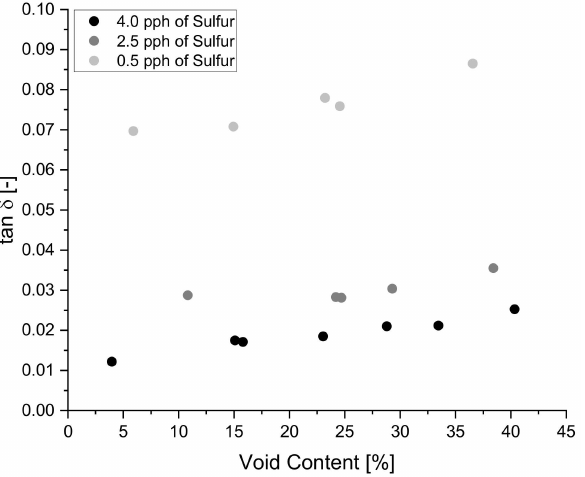
Figure 18. The influence of sulfur content and void content on tan δ for blends 7, 8 and 9.